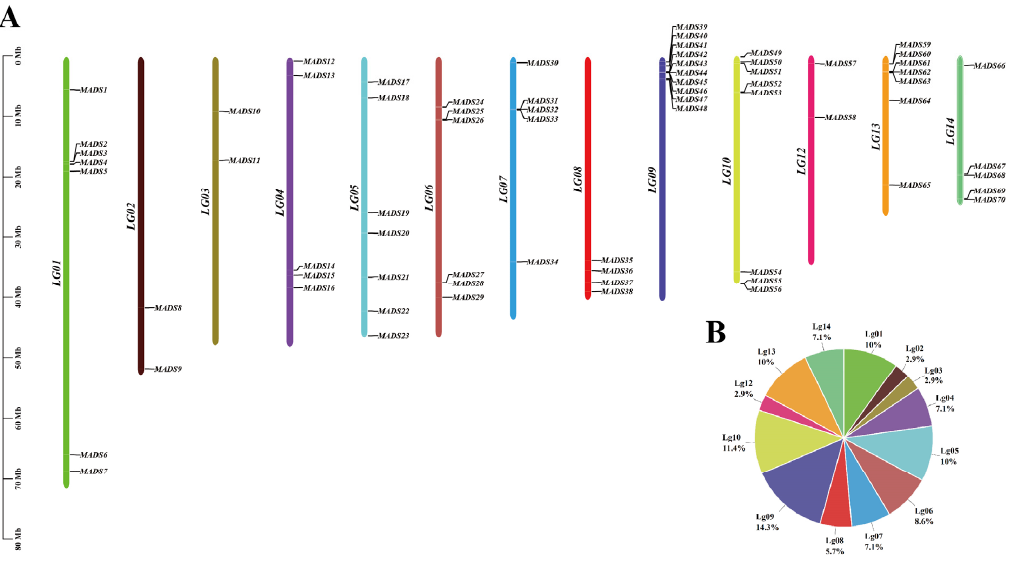
Figure 2. Chromosome location of the SeMADS-box. ( A ) Each chromosome is indicated in di ff erent colors. ( B ) The pie chart shows the percentage of MADS-box genes on each chromosome. colors. ( B ) The pie chart shows the percentage of MADS-box genes on each